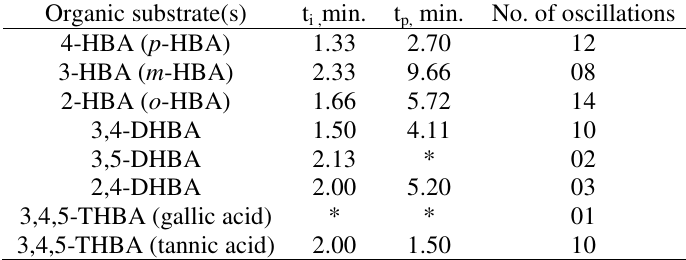
Figure 1. Potential time plots of the systems comprising of various isomers of hydroxybenzoic acid (0.0070 M) each; [BrO H SO at 35 o .± 0.2 o C. 2 4 Table 1. Effect of hydroxyl groups on the oscillatory parameters of the isomers of hydroxybenzoic acid in the system containing [ o HBA] = [ m HBA] = [ p HBA] = [3,4-DHBA] = [3,4,5-THBA] = 0.0070 M; [ BrO 3- ] = 0.0750 M; [ Mn 2+ ] = 0.0080 M; [H and Temperature = 35 o .± 0.2 o